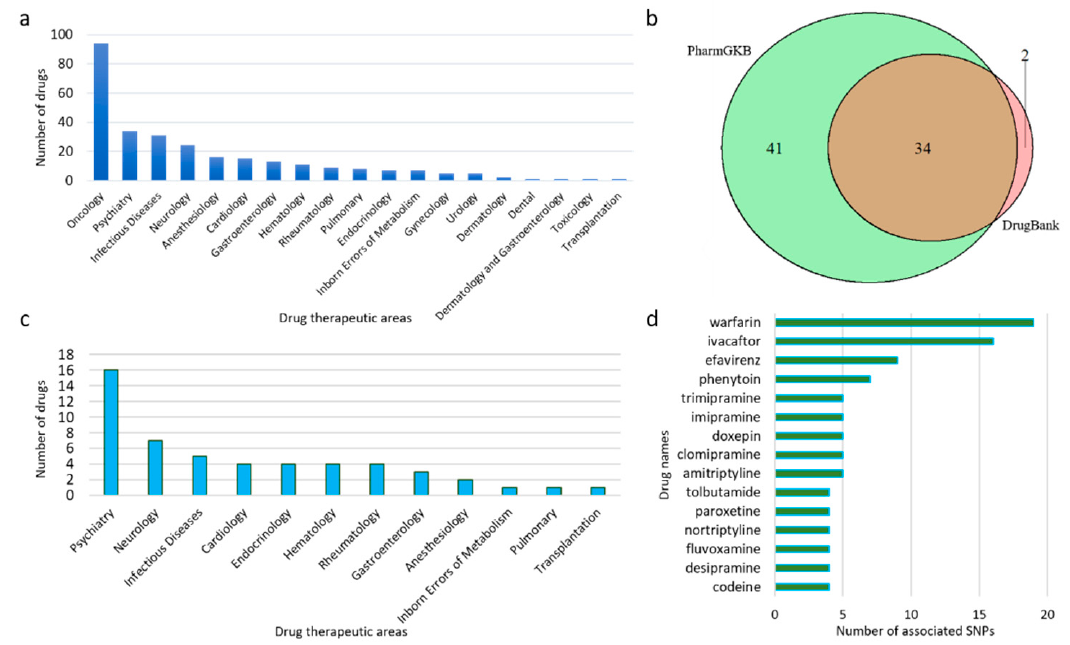
Figure 2. Summary of data collection by drugs. ( a ) The distribution of all drugs with PGx information in drug labels across therapeutic areas. ( b ) The numbers of non-oncology drugs with PGx information that were from PharmGKB and DrugBank. PharmGKB and DrugBank shared a great portion of drugs from our selection. ( c ) The distribution of therapeutic areas for non-oncology drugs with information on SNP allele frequency in six ethnic groups. ( d ) Top drugs that interact with the greatest number of SNPs with reported allele frequency information.